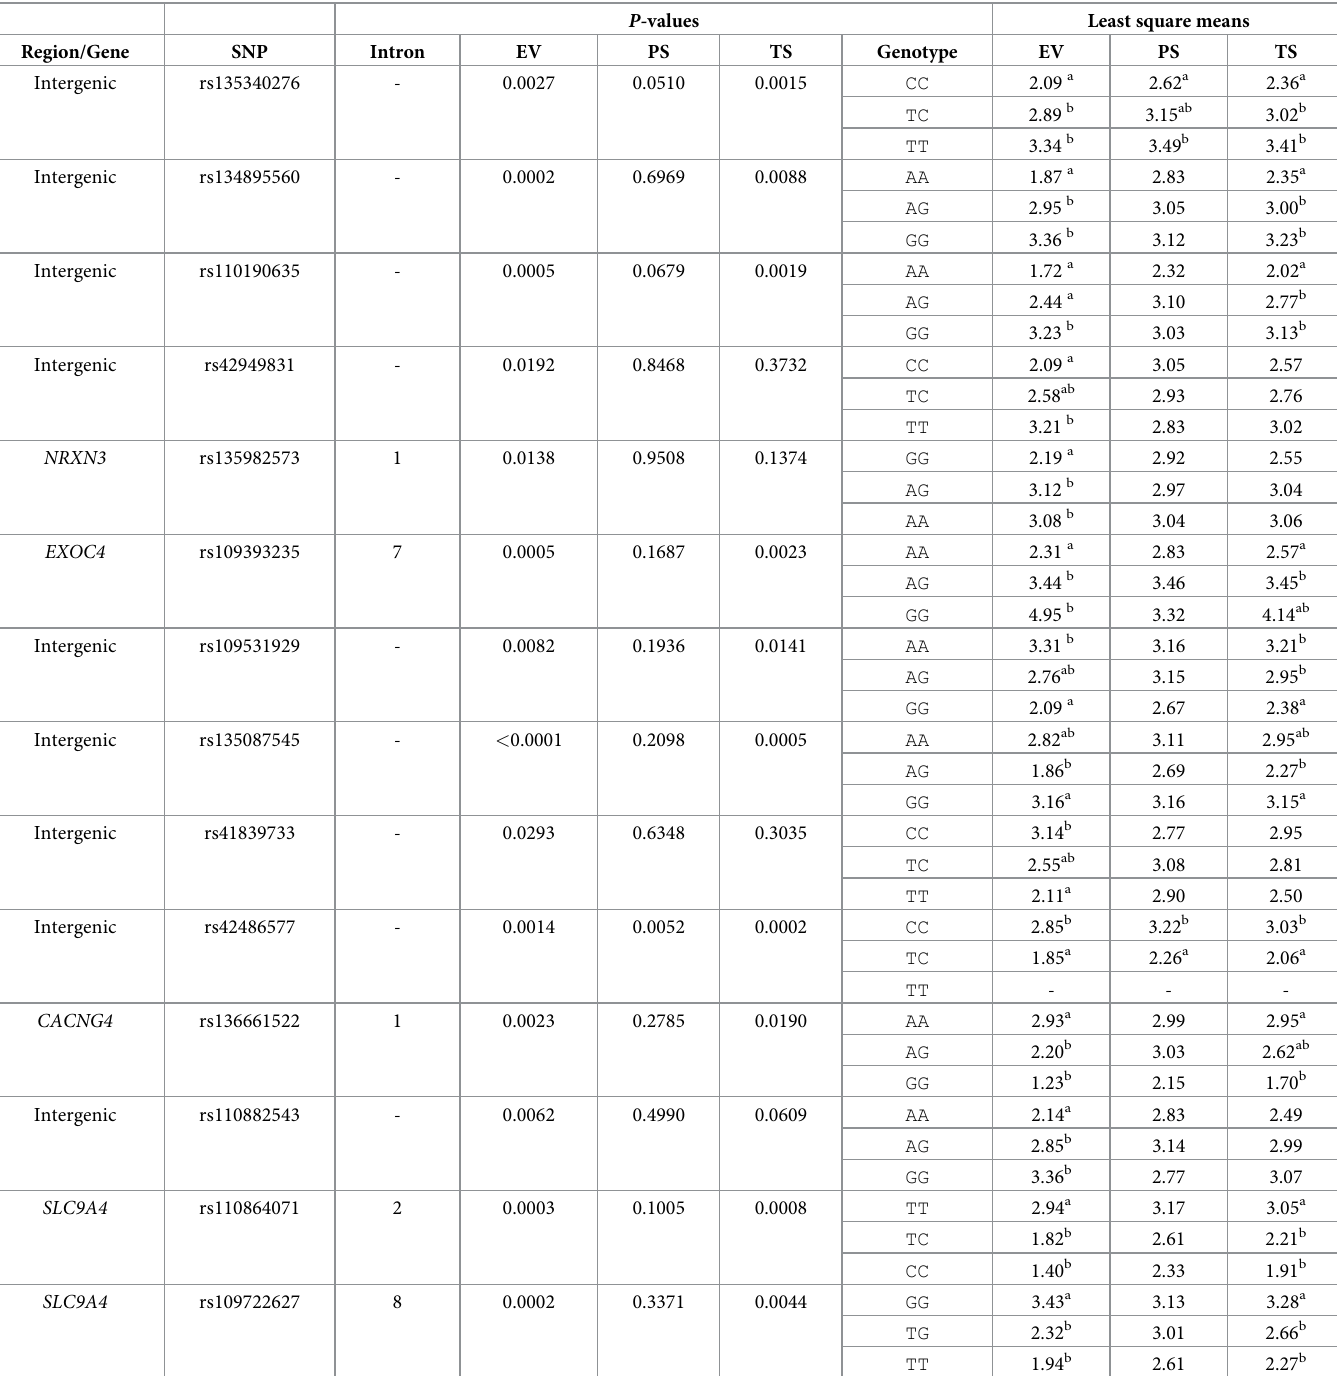
Table 3. Least square means of genotype effects of SNPs associated with Brahman temperament traits using a mixed model